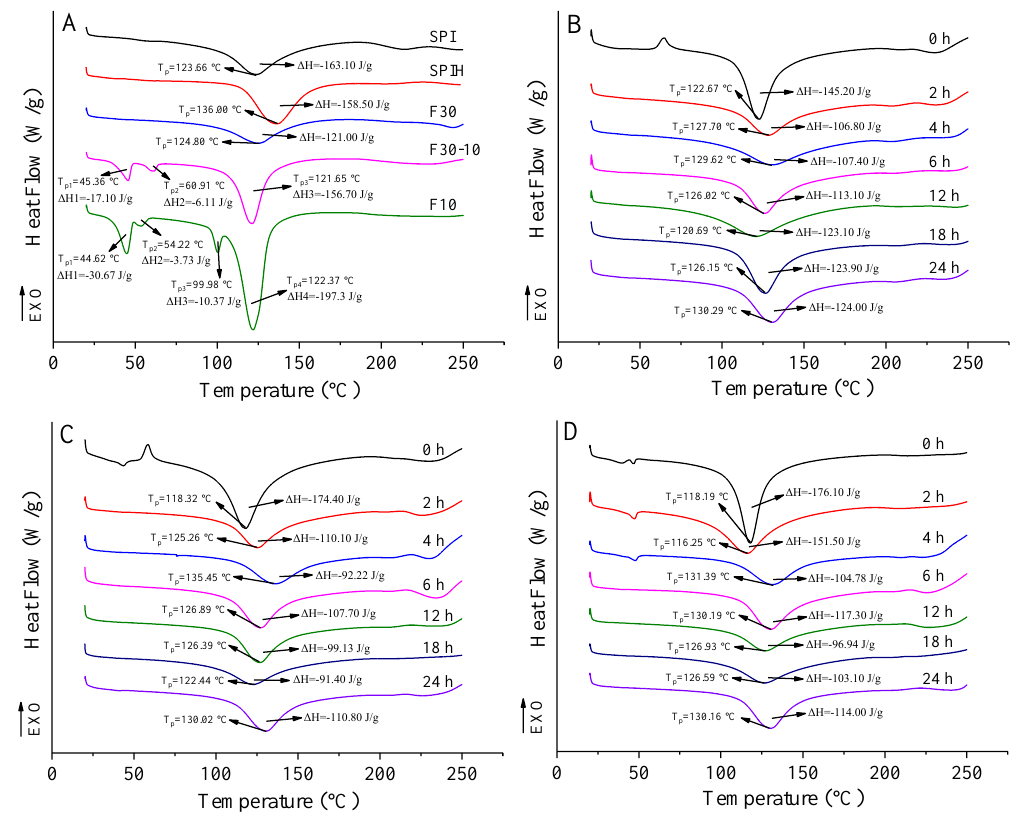
Figure 5. Thermograms of SPI, SPIH, F30, F30-10, and F10 ( A ); F30-dextran ( B ); F30-10-dextran ( C ); and F10-dextran ( D ) conjugates incubated for 0, 2, 4, 6, 12, 18, and 24 h.